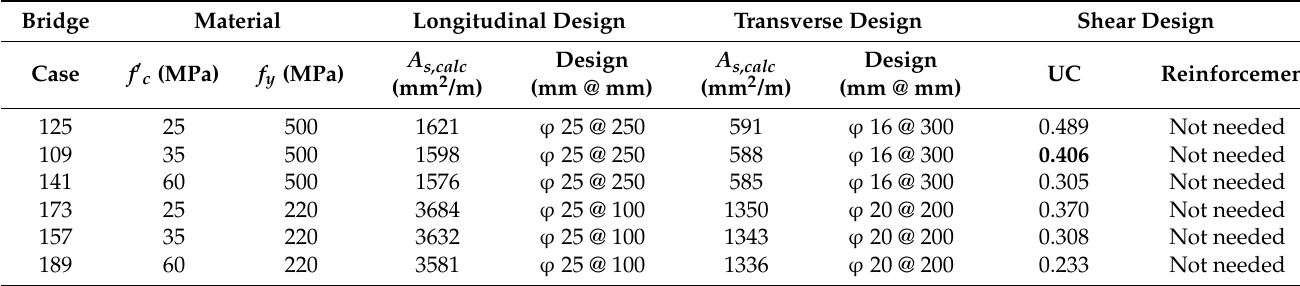
Table 5. Designed reinforcement for the 7.5 m long, four-lane, 15 ◦ skew case study bridge using LFEA when varying the material properties.